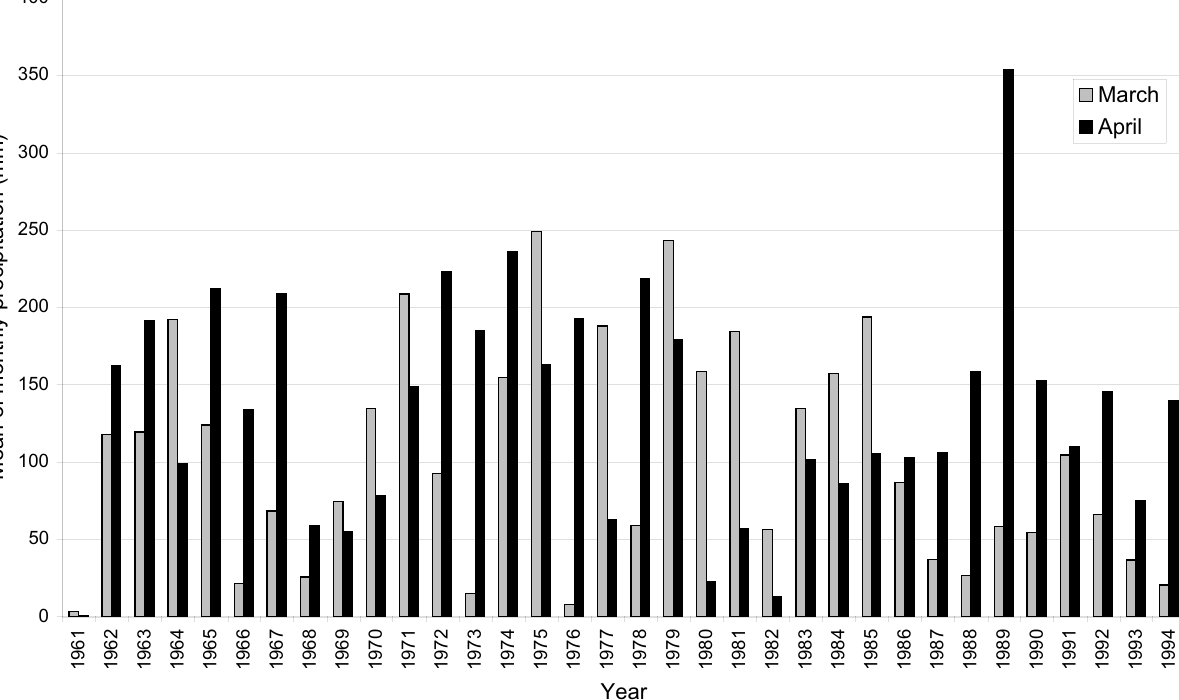
Fig. 2. Mean monthly precipitation during March and April in the Fagarè, Padova, Italy, area from 1961 to